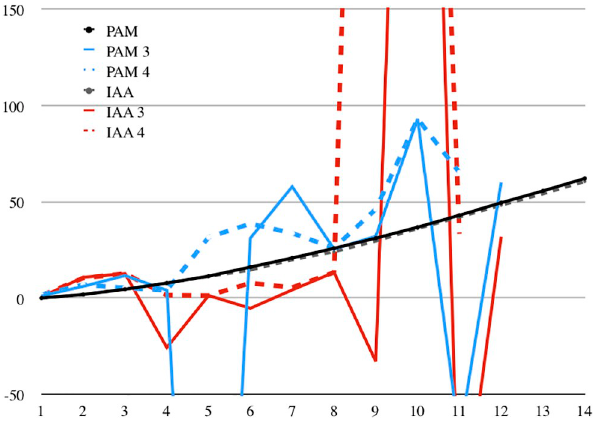
Fig 9. 11Q11 ( Apocryphal Psalms ). Measured length compared to calculated lengths in cms. See legend at Fig 7.